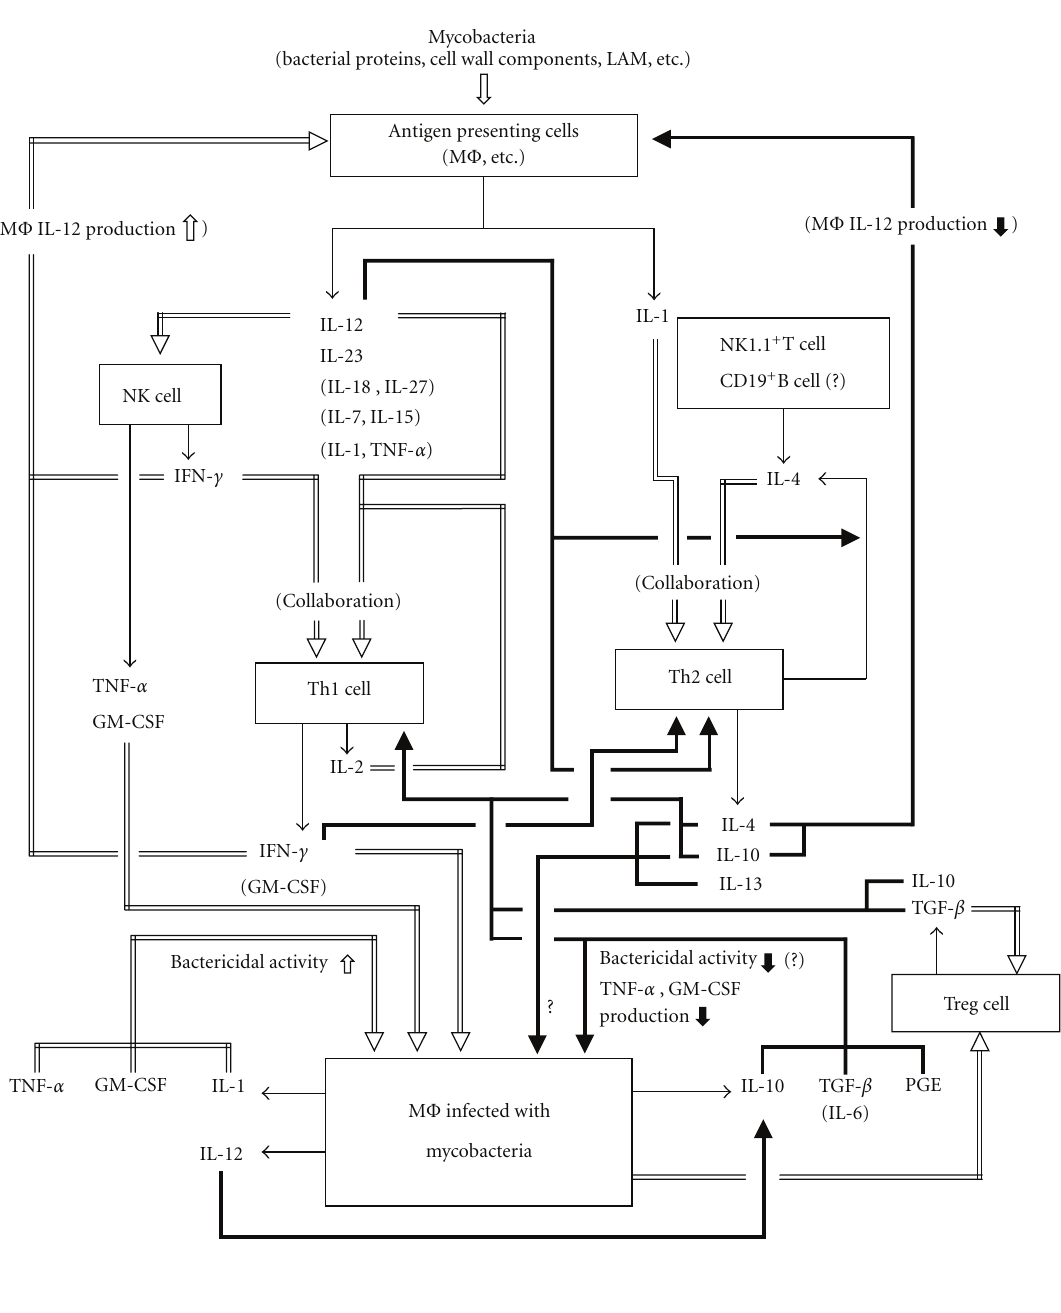
Figure 1: Cytokine networks in hosts with mycobacterial infection. In this cytokine network, proinflammatory cytokines, including IL- 12, IL-23, IL-18, and tumor necrosis factor- α (TNF- α ), which are produced by infected macrophages (M Φ s) and dendritic cells (DCs), induce the cellular expansion and di ff erentiation of Th1 cells, resulting in enhanced production of Th1 and Th1-like cytokines, such as interferon- γ (IFN- γ ), IL-2, TNF- α , and granulocyte-macrophage colony-stimulating factor (GM-CSF). These cytokines play crucial roles in the expression of host resistance against mycobacterial infections. In addition, immunosuppressive cytokines and humoral factors, such as IL-4, IL-10, transforming growth factor- β (TGF- β ), and prostaglandin E (PGE), which are produced by Th2 cells, Treg cells, Th3 cells, and macrophages, appear to play important roles in the establishment of immunodeficiency frequently encountered in persistent and advanced infection with mycobacterial pathogens, including